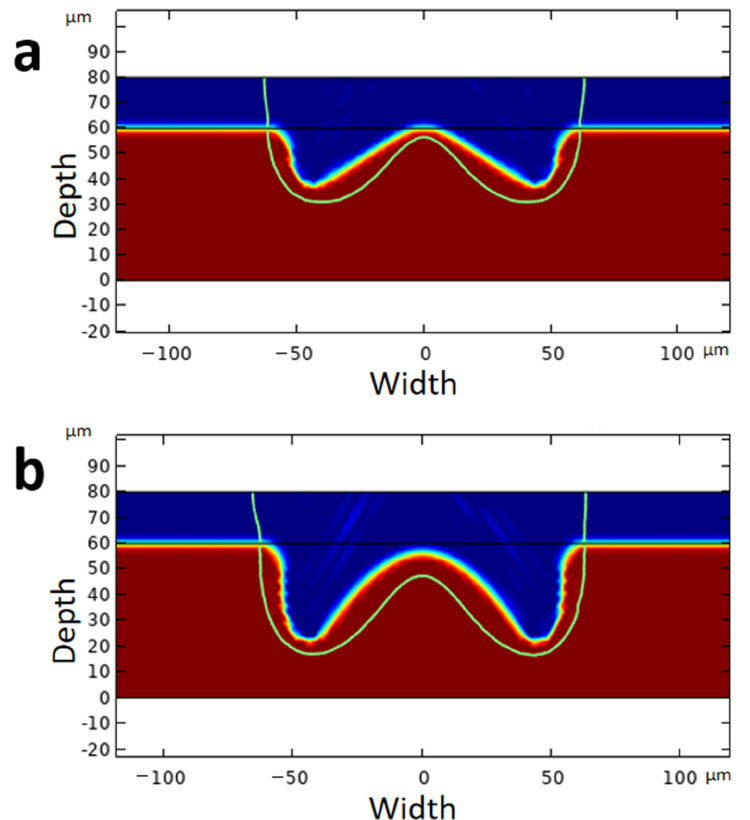
Figure 6. Simulation results for the temperature and micro hole shape at t = 0.12 ms under different laser powers: ( a ) 15 W; ( b ) 17.5